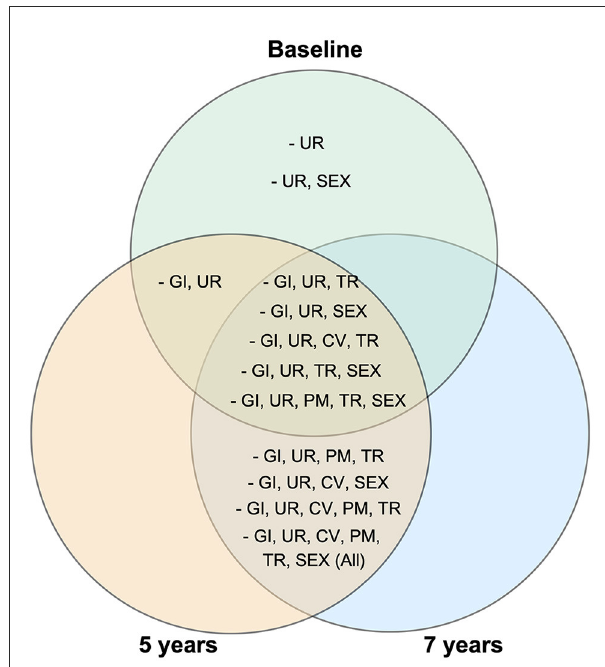
FIGURE3 Venn diagram showing specific combinations of autonomic symptoms present in at least 10 Parkinson’s disease participants at baseline, 5 years and 7 years follow ups. GI, gastrointestinal; UR, urinary; CV, cardiovascular; TR, thermoregulatory; PM, pupillomotor; SEX, sexual domain.